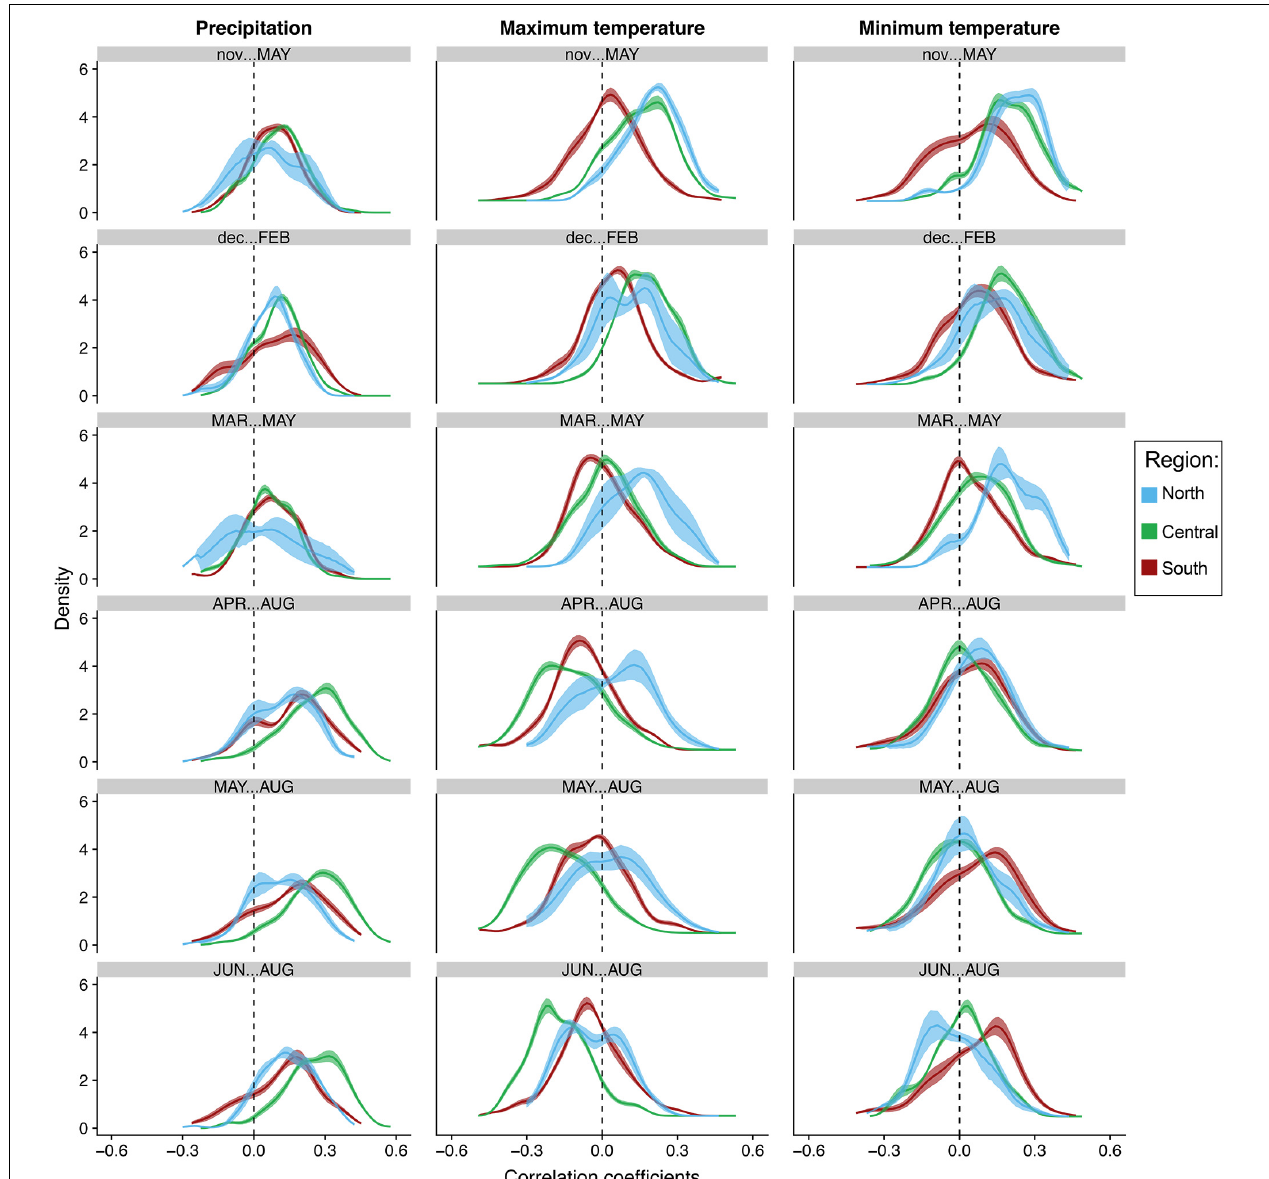
FIGURE 6 | Bootstrapped distributions of correlations of population-level growth to seasonal total precipitation and average maximum and minimum temperatures at the regional level. Blue represents the northern end of our network (North), green represents the central region (Central), while brick red represents trees in the southern portion of our network (South). Solid lines represent the mean. Shading represents 100 bootstrapped